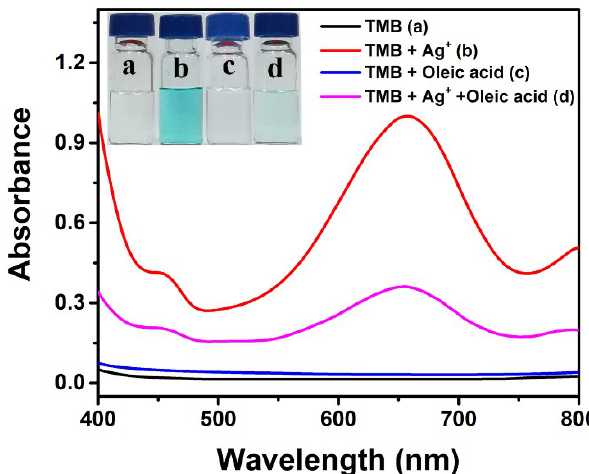
Figure 1. UV-vis absorption spectra of 0.3 mM TMB ( a ) without 0.175 mM Ag + and 1 μM oleic acid, ( b ) with 0.175 mM Ag + and without 1 μM oleic acid ( c ) with 1 μM oleic acid and without 0.175 mM Ag + , ( d ) with 0.175 mM Ag + and 1 μM oleic acid. The inset shows the corresponding digital photo.